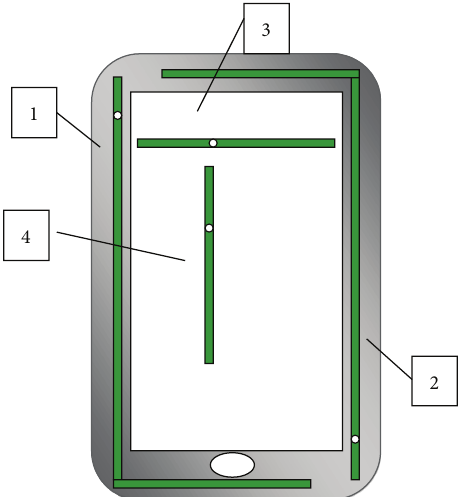
Figure 10: The schematic diagram of MIMO wideband antenna solution for LTE smart